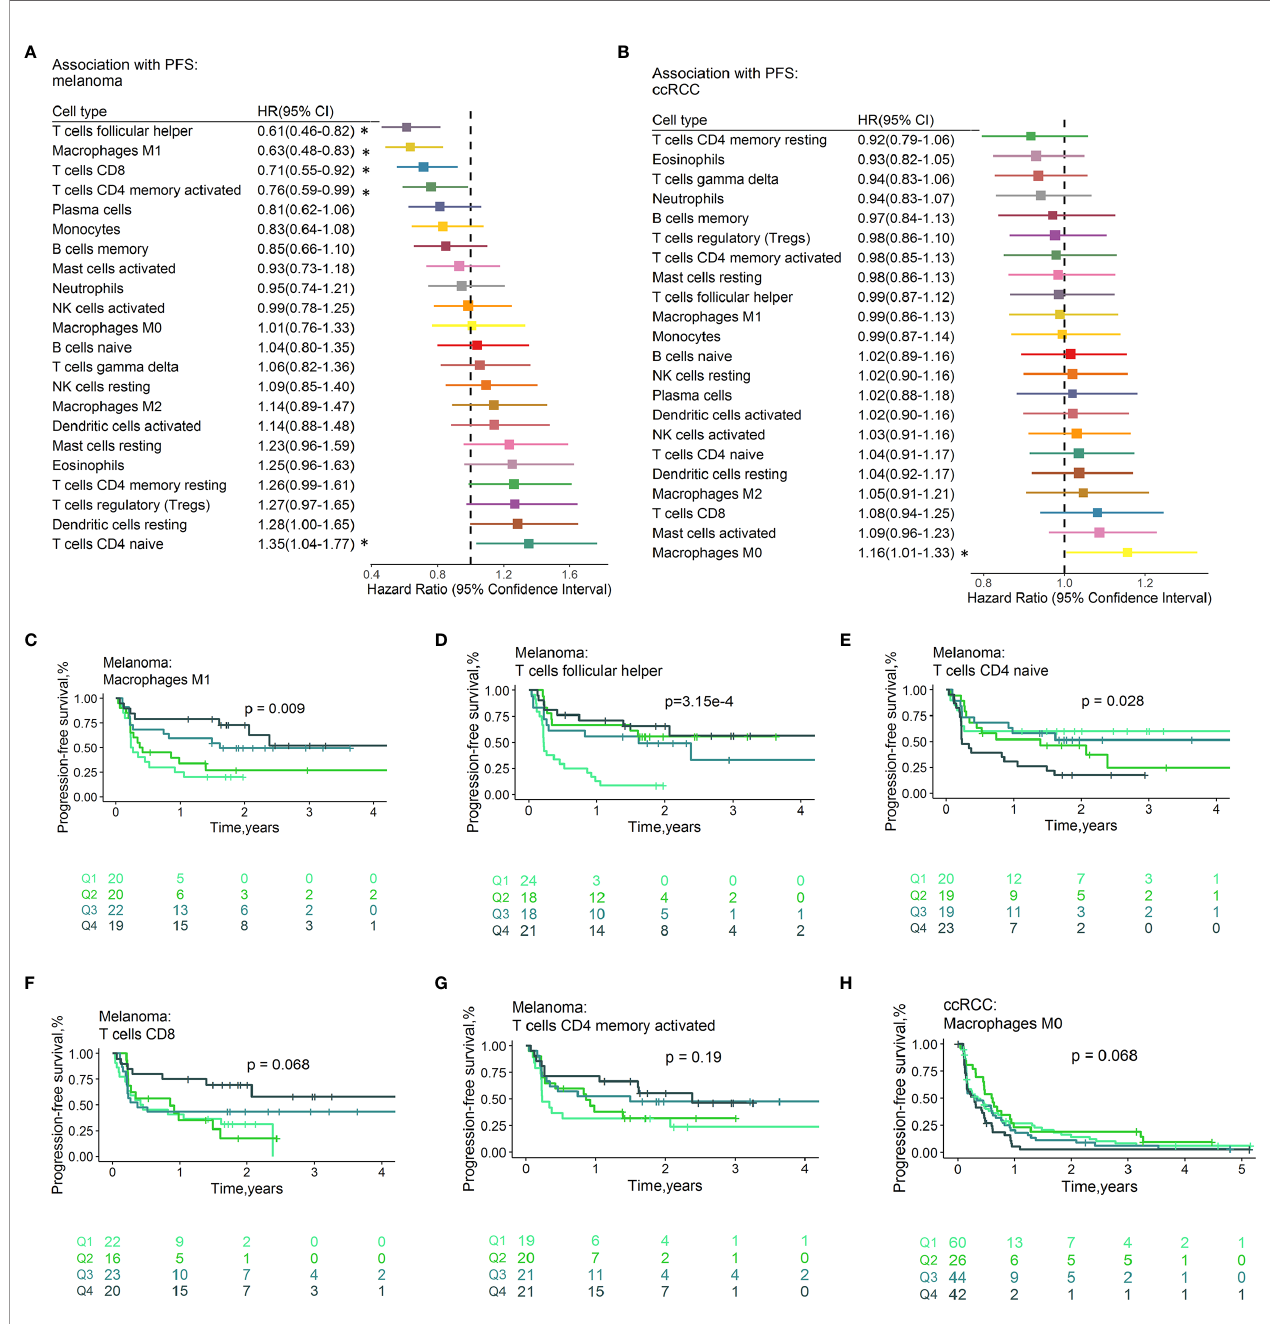
FIGURE 5 | Associations between PFS and immune cell subtypes. Forest plot demonstrating HRs (boxes) and 95% CIs (horizontal lines) for the association with PFS after ICI therapy in melanoma (A) and ccRCC (B) . The results were obtained from univariate Cox regression analysis. The size of the box is negatively proportional to the standard error of the HR. * denote HRs with a p-value < 0.05. Survival curves of quartiles of immune cell fractions (C – H) . Illustrated p-values are from log-rank tests. HR, hazard ratio, OS, Overall survival, CI, con fi dence